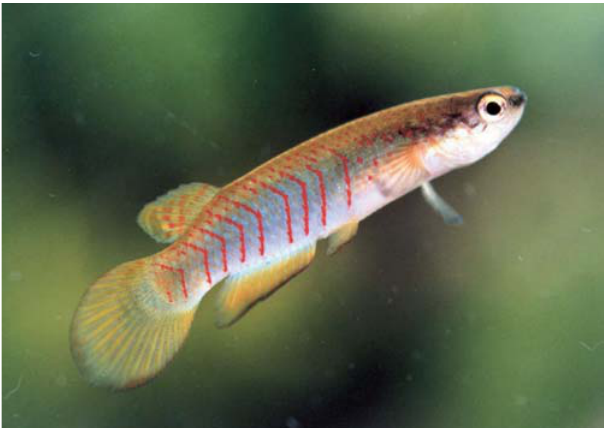
Fig. 11. Rivulus egens , UFRJ 5973, male, holotype, 25.2 mm SL (one day after collection); Brazil: Mato Grosso do Sul: Camapuã. Photo by W. J. E. M. Costa.